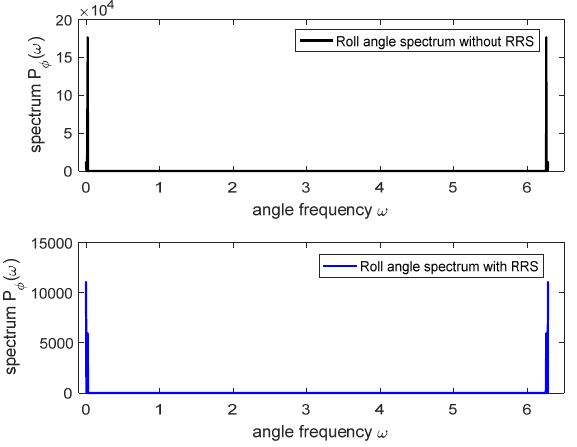
Figure 10. Power spectrum of roll angle with and without RRS.